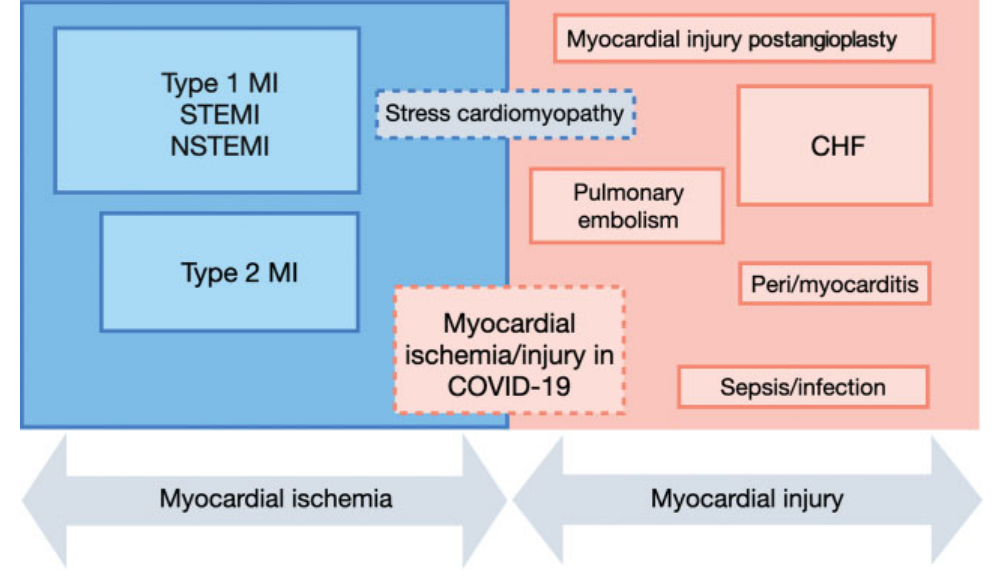
Fig. 2 Clinical evidence of acute myocardial ischemia and myocardial injury during the COVID-19 pandemic. COVID, coronavirus disease; MI, myocardial infarction; STEMI, ST-elevation